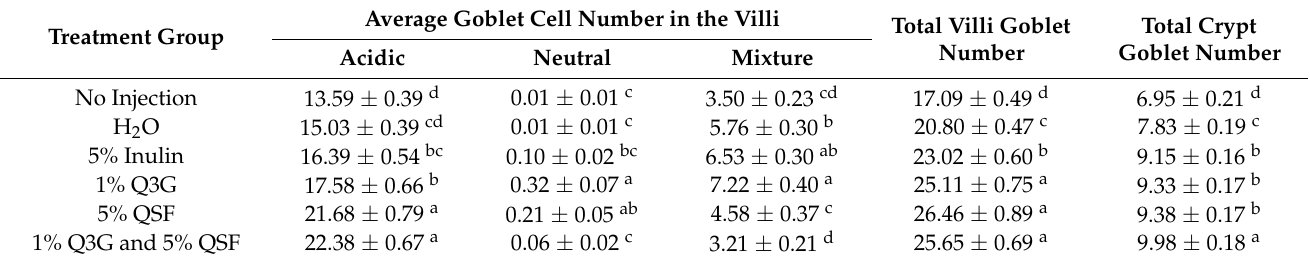
Table 2. Effect of intra-amniotic administration of treatments and controls on goblet cell type and total number of goblet cells in duodenal villi and crypts.